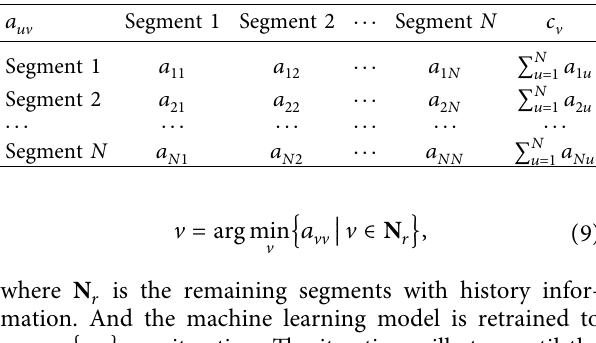
Table 1: Attention coefficients between the remaining